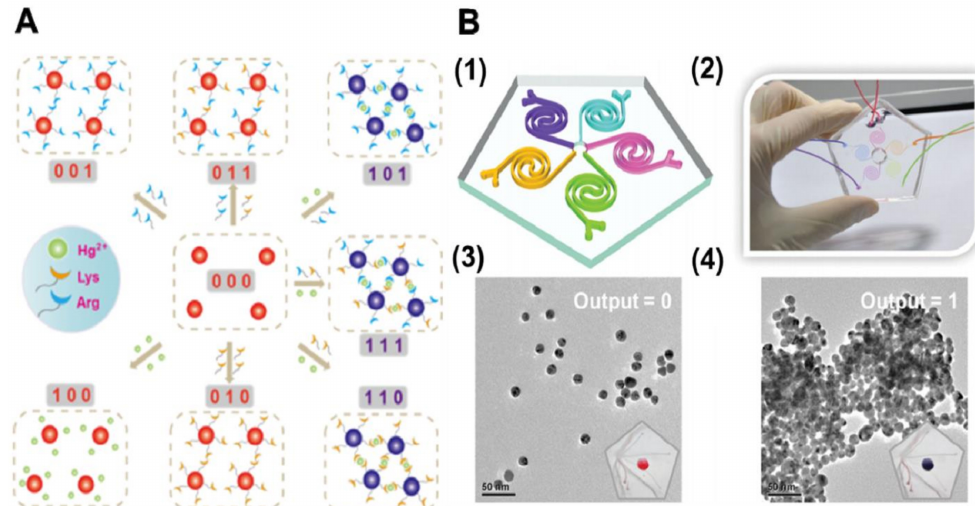
Figure 31. Modification of Au NPs for biochemical analysis by amino acid mediated surface. ( A ) A colorimetric (AND+OR) logic scheme that uses Au NPs with arginine/lysine. ( B ) Microfluidic systems for metal ion detection combined with molecular logic gates. Schematic diagram and microfluidic chip photographs are presented in panels ( 1 ) and ( 2 ). TEM photos and the required observation window color of the Au NPs are in panels ( 3 ) and ( 4 ). Copyright 2014, Wiley, adapted by reference permission [217], Copyright 2014, Wiley.